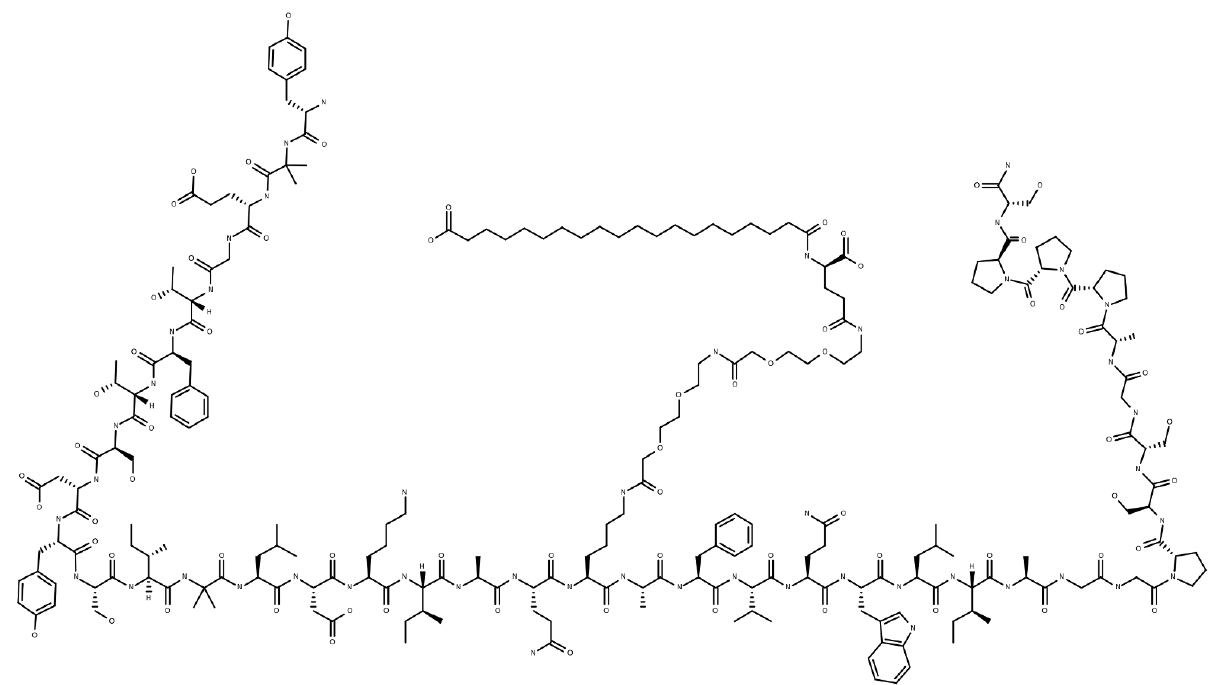
Figure 1. Structure of Tirzepatide (39 amino acids), a dual GIP/GLP-1 receptor agonist (twincretin) that has two non-coded amino acid residues ( α -aminoisobutyric acid) at positions 2 and 13 and that has two non- coded amino acid residues (α -aminoisobutyric acid) at positions 2 and 13 and is acylated on K20 with a γGlu -2×OEG linker and C18 fatty diacid moiety.